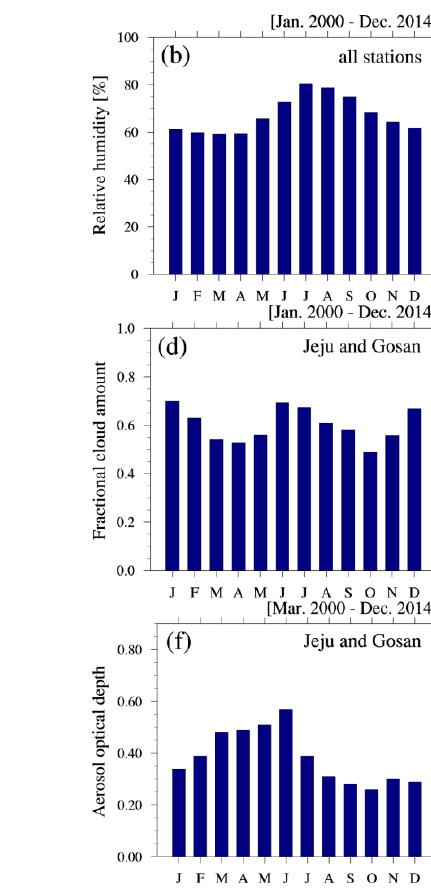
Figure 2. Temporal variations in monthly mean K T values averaged over all 21 sites. Data are shown for all sky (black circles), clear sky (red circles), and overcast sky (green circles).